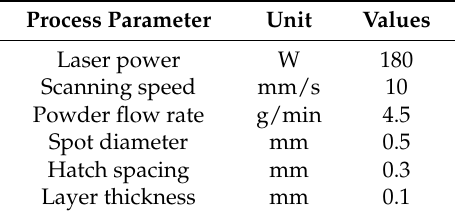
Table 2. Process parameters of laser cladding